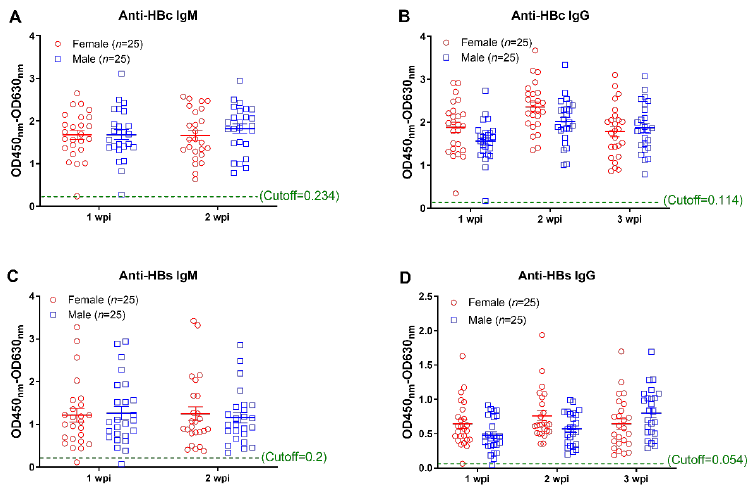
Figure 2. Monitoring of antibody responses against HBV core and surface proteins at the early phase infection. Antibody responses against HBc and HBs were measured by the method of ELISA. ( A ) the anti-HBc IgM responses at 1 week post infection (wpi) and 2 weeks post infection; ( B ) the anti-HBc IgG responses at 1 wpi, 2 wpi, and 3 wpi; ( C ) the anti-HBs IgM responses at 1 wpi and 2 wpi; ( D ) the anti-HBs IgG responses at 1 wpi, 2 wpi, and 3 wpi. Data were shown as mean ± SD. Statistical